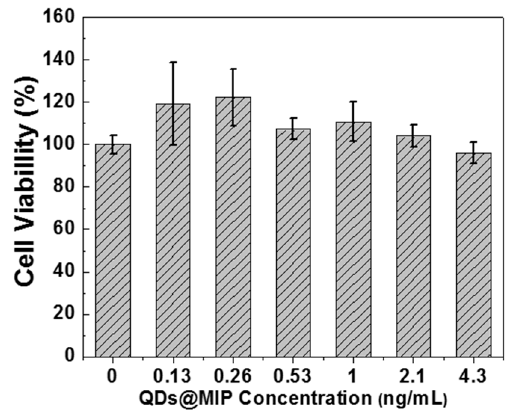
Figure 6. WST-1 assay on THP-1 cell line when varying the concentration of QDs@MIP particles from 0.13 to 4.3 ng / mL. Values represent means ± S.E ( n = 3).